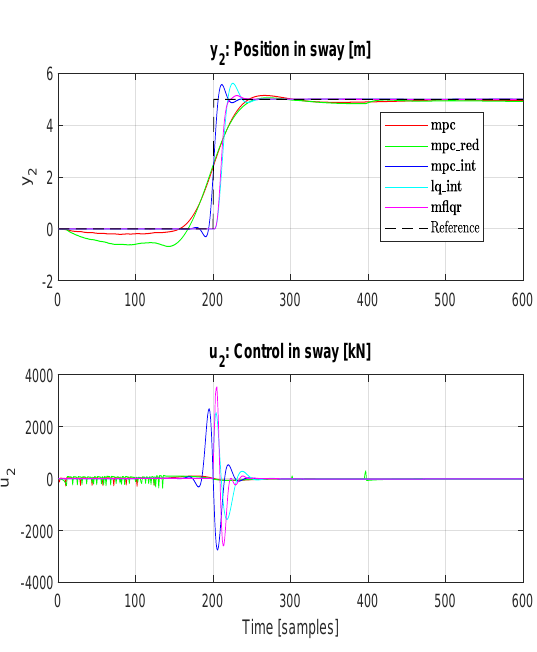
Figure 5: The figure shows the reference/setpoint step in sway position for the five different DP sys- tems controller algorithms.